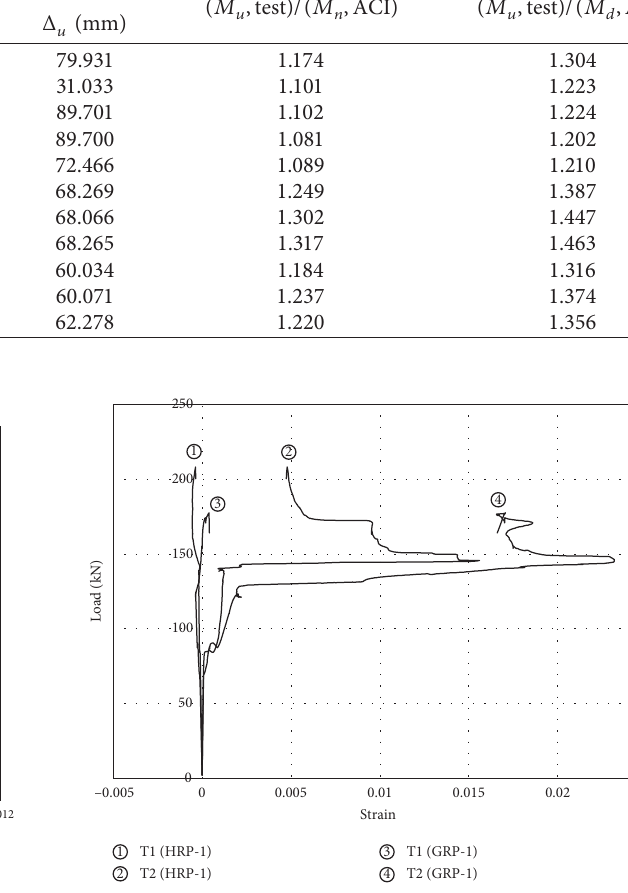
Figure 10: Concrete strain. Figure 11: Rebar